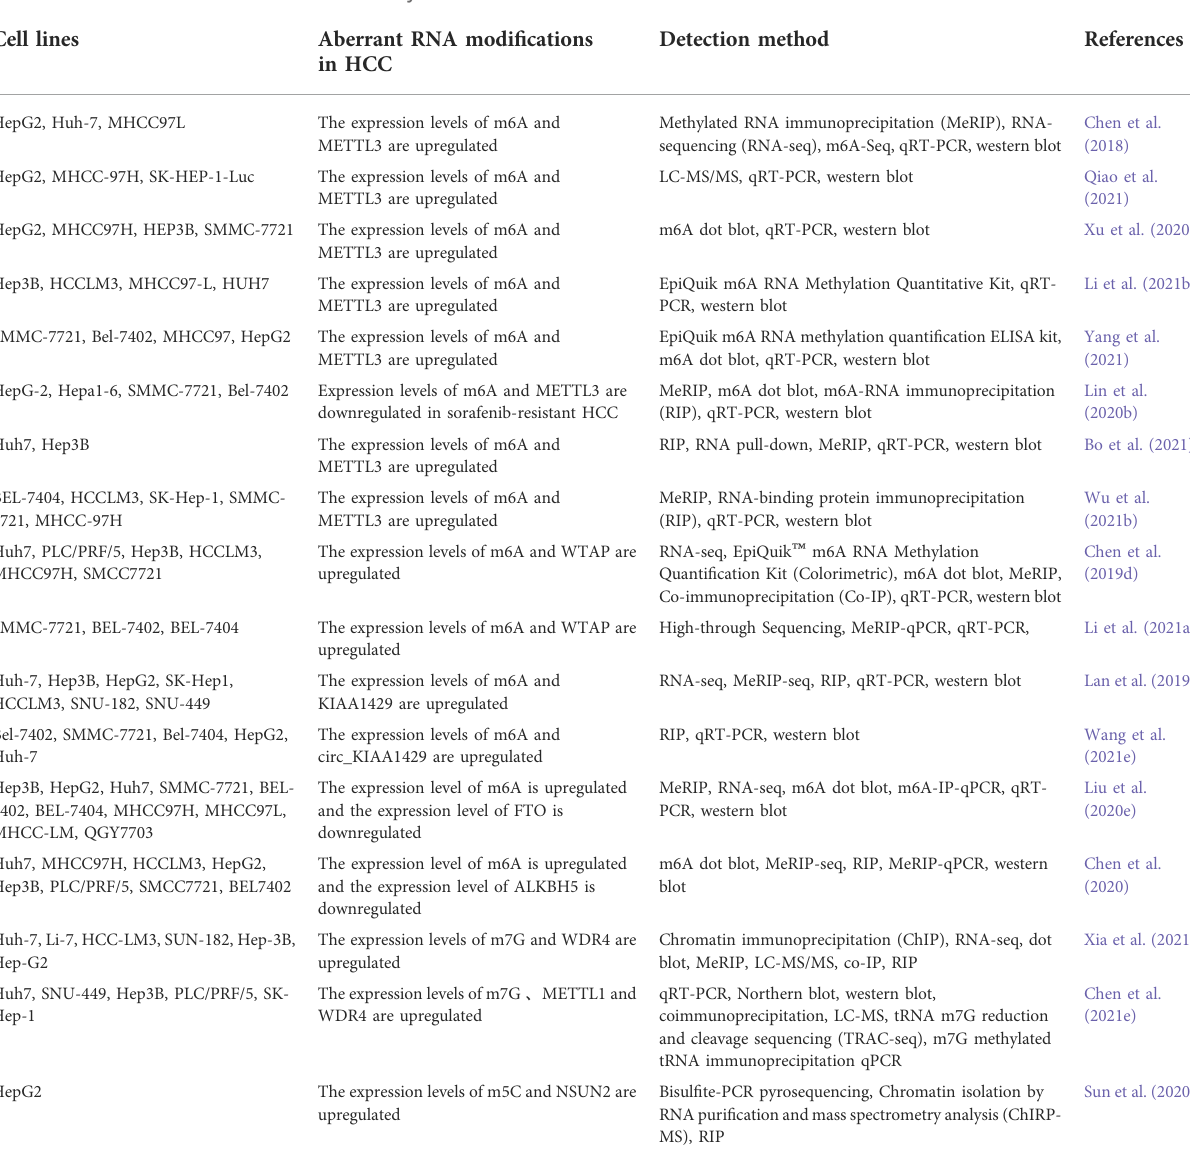
TABLE 1 HCC cell lines and RNA modi fi cation